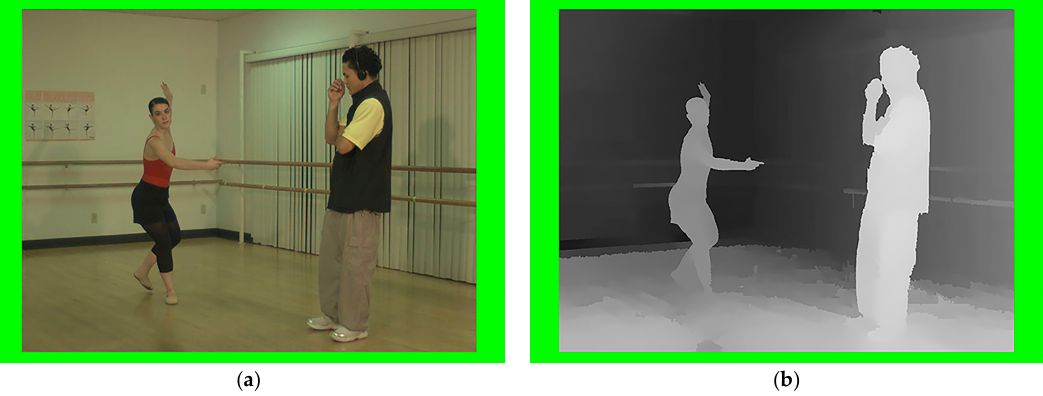
Figure 4. Extended reference image and its depth image: ( a ) Extended reference image; and ( b ) extended depth image.